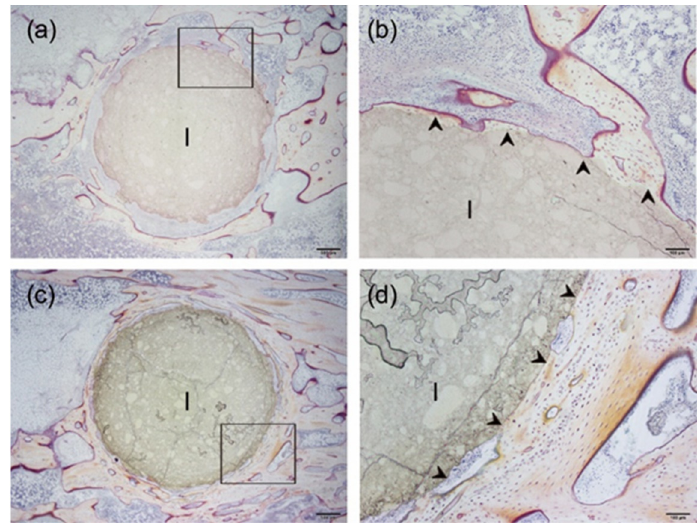
Figure 8. In vivo biocompatibility of protamine / HAp discs in a rabbit tibia. HAp ( a , c ) or protamine / HAp ( b , d ) discs were implanted in rabbit tibiae for 8 weeks. Villanueva bone staining of each specimen (I) showed the newly formed bones (arrowheads) were directly in contact with discs. ( b ) and ( d ) are highly magnified images of ( a ) and ( c ), respectively. Bars in ( a ) and ( c ) indicate 500 µ m, and ( b ) and ( d ) indicate 200 µ m, respectively.